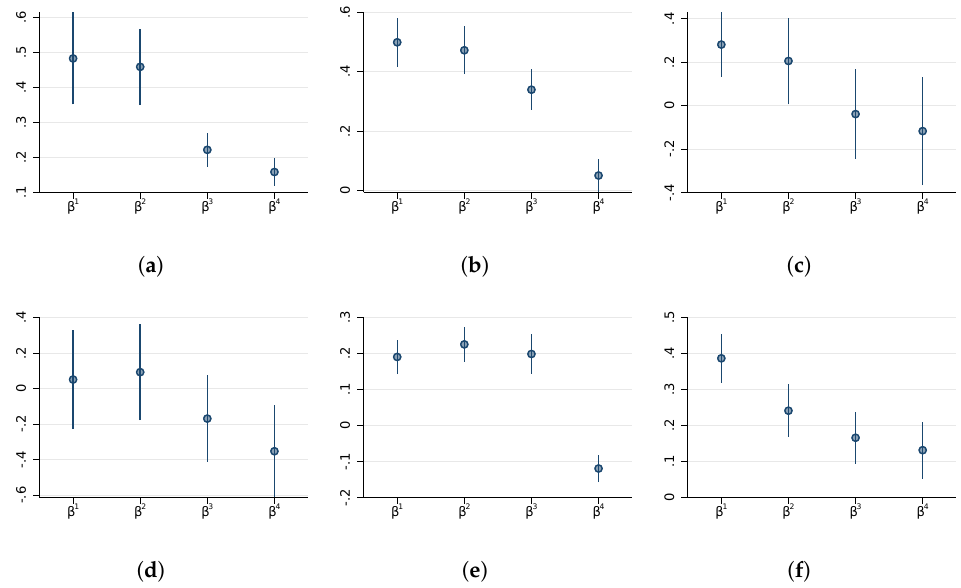
Figure 2. Income elasticity of nightlights for samples split by quartiles of average GDP. ( a ) USA, ( b ) Germany, ( c ) Italy, ( d ) Spain, ( e ) Brazil, ( f )